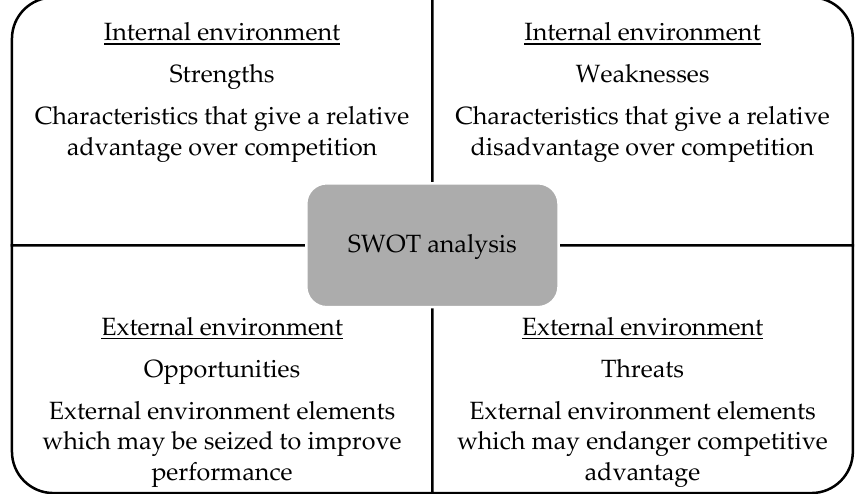
Figure 4. Framework of SWOT analysis. Source: authors.